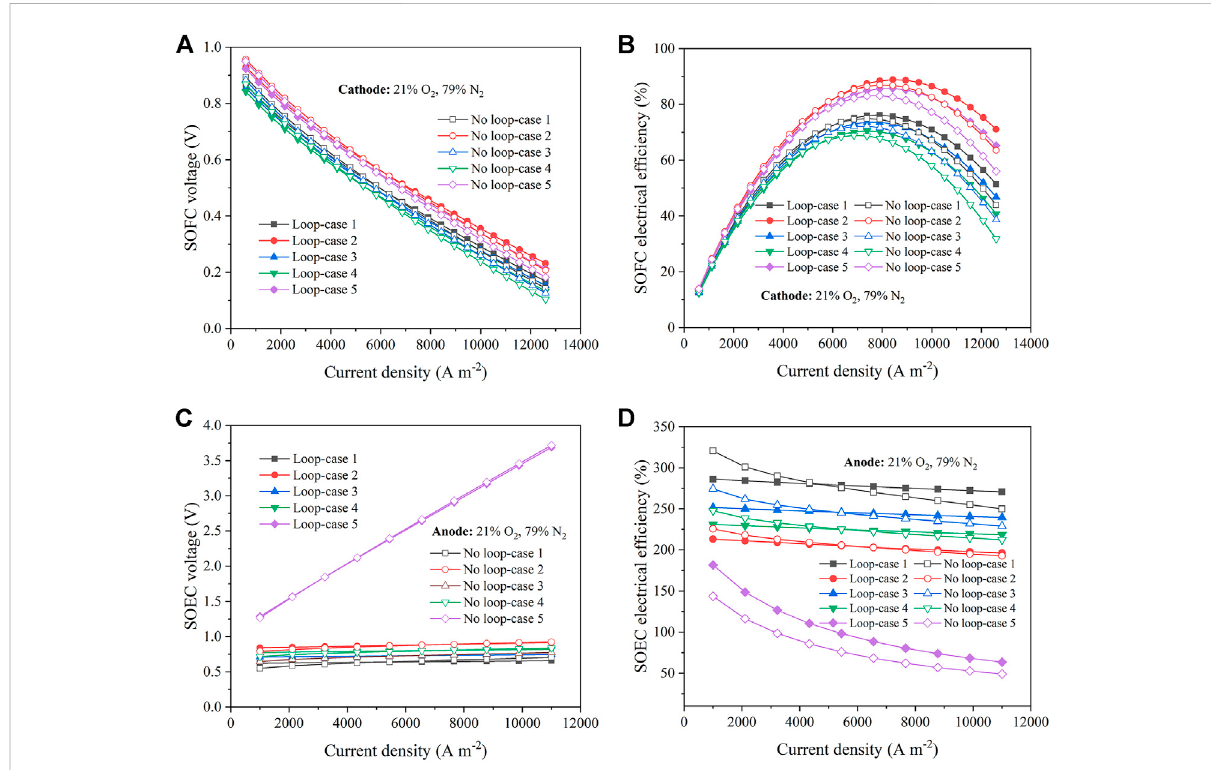
FIGURE 7 Performances under fi ve different fuel inlet schemes (A) Output voltage of SOFC; (B) SOFC electrical ef fi ciency; (C) SOEC electrolytic voltage; (D) SOEC electrolytic ef fi